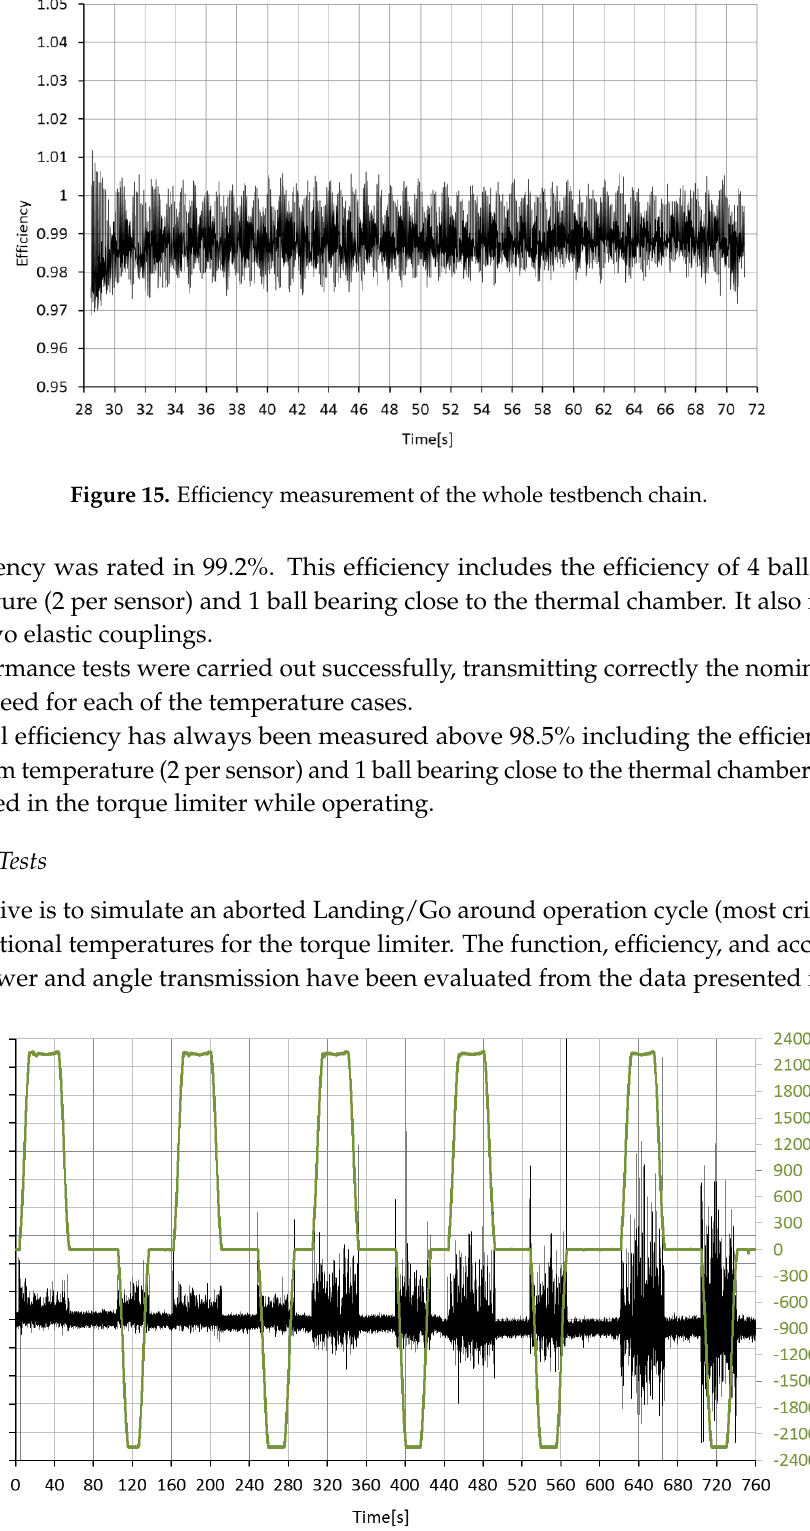
Figure 16. Temperature stabilization measurement.